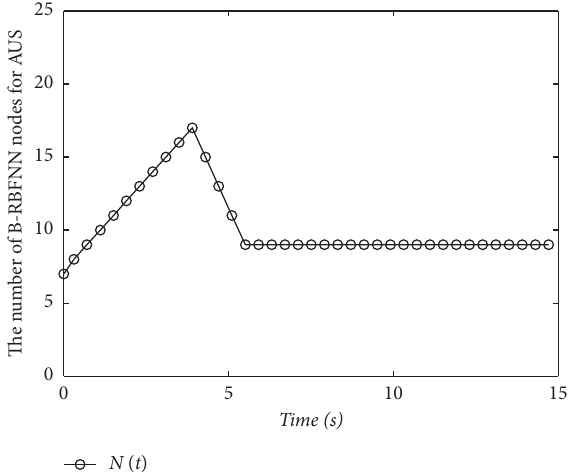
Figure 9: Trajectory of the B-RBFNN nodes number of CAUSs.